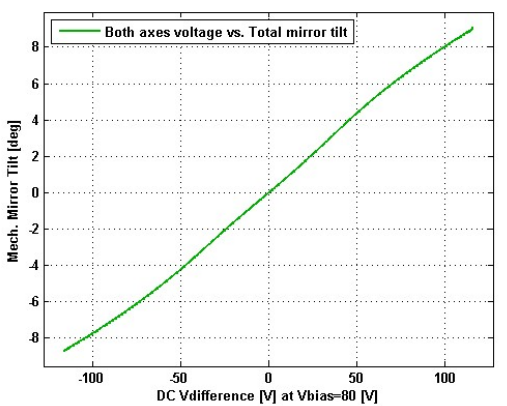
Figure 2. Voltage vs. mech. angle—coupled axes of the MEMS micromirror (supplementary mate- rial) .